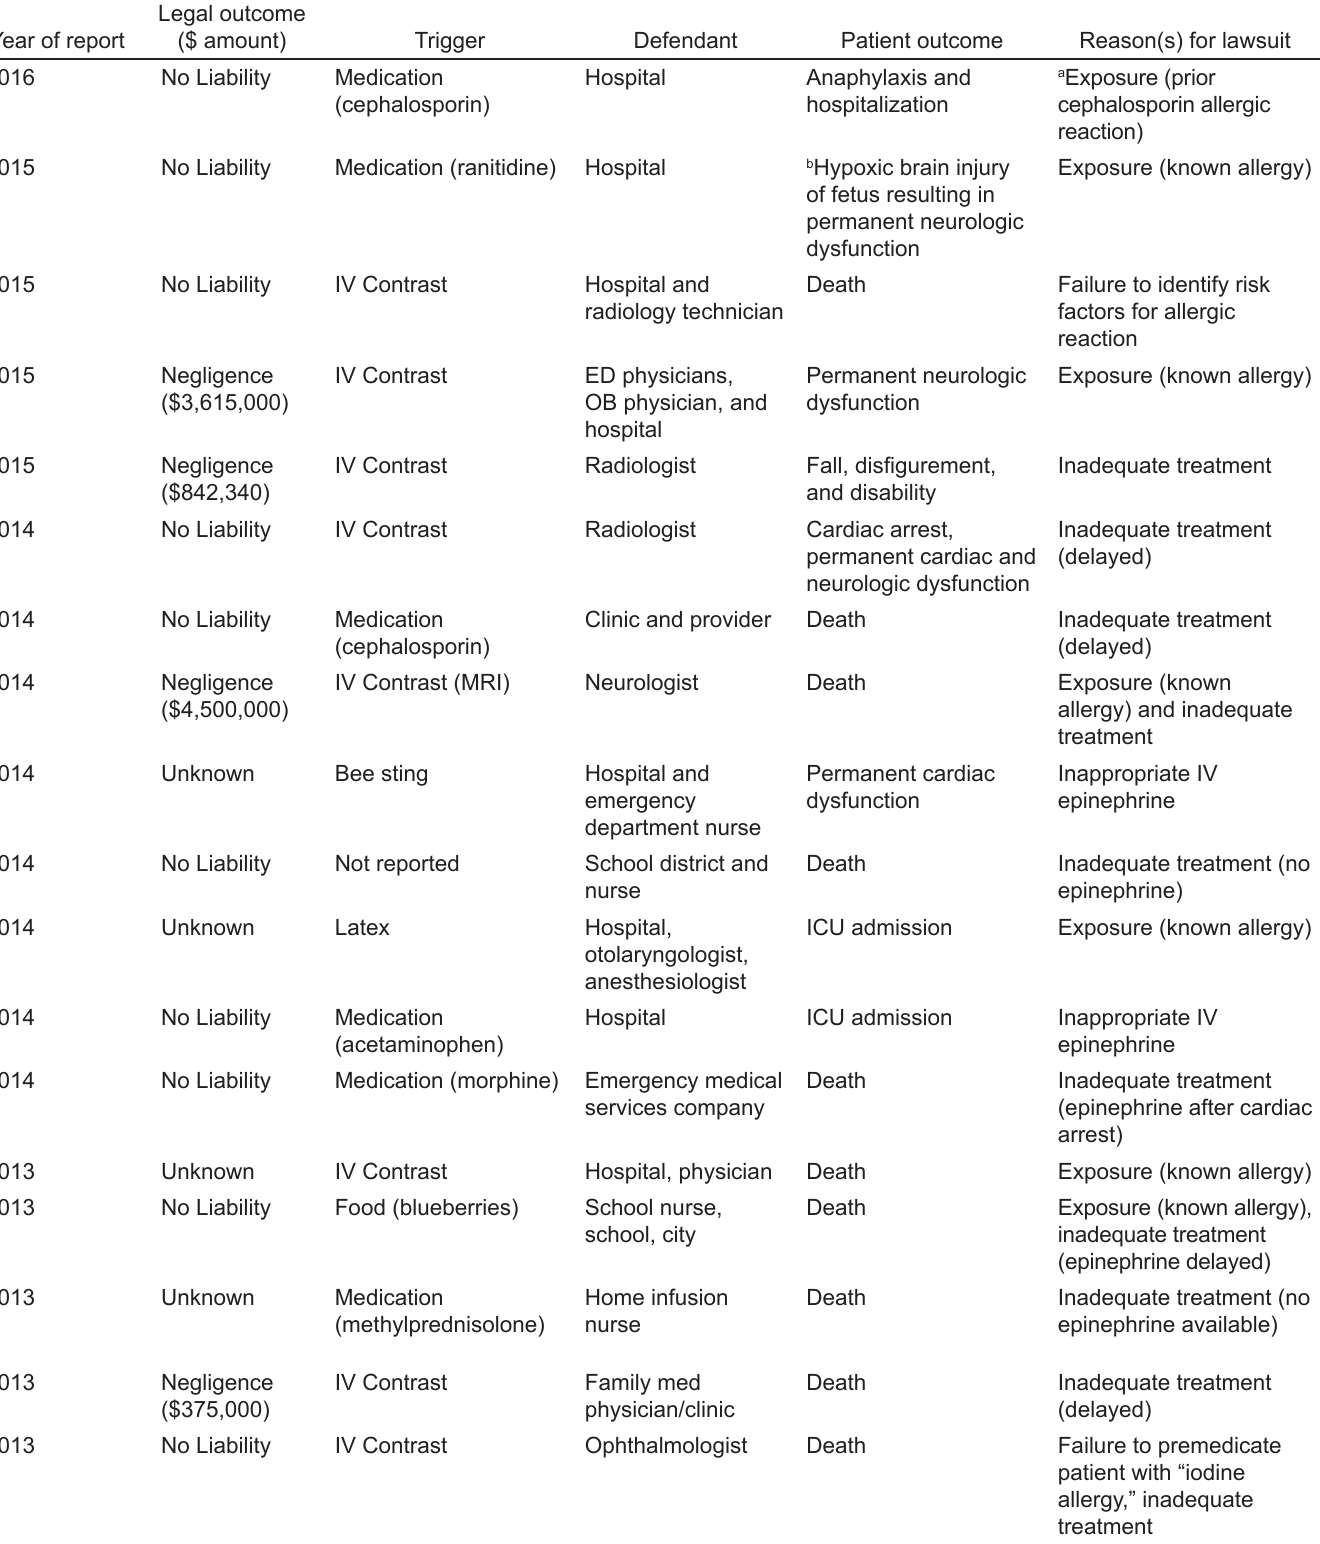
Table 2. Summary table of Individual legal cases related to anaphylaxis.